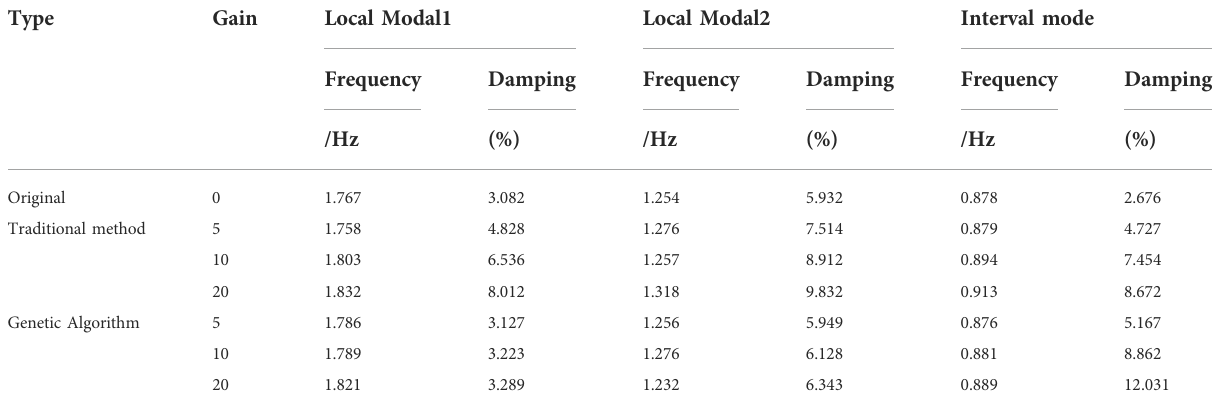
TABLE 1 Suppression effects of TCSCs designed by different methods on various modes.